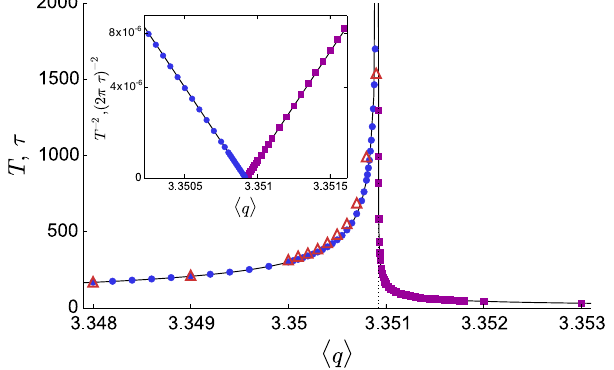
FIG. 3. Characteristic times associated with the k -core pruning process for k ¼ 3 on an Erd ő s-Rényi network. Circles show the duration T of the entire pruning process below h q i c . Squares show the relaxation time constant τ above h q i c . Fitted square-root scaling for T and τ are shown by black solid lines. The critical point h q i c is marked by a vertical dotted line. Completion times for a simulated network of 10 8 vertices are also shown below h q i c (triangles). In the inset, the inverse squares of T and τ (also scaled by 2 π ) are shown, demonstrating the inverse square dependence on the distance from the critical